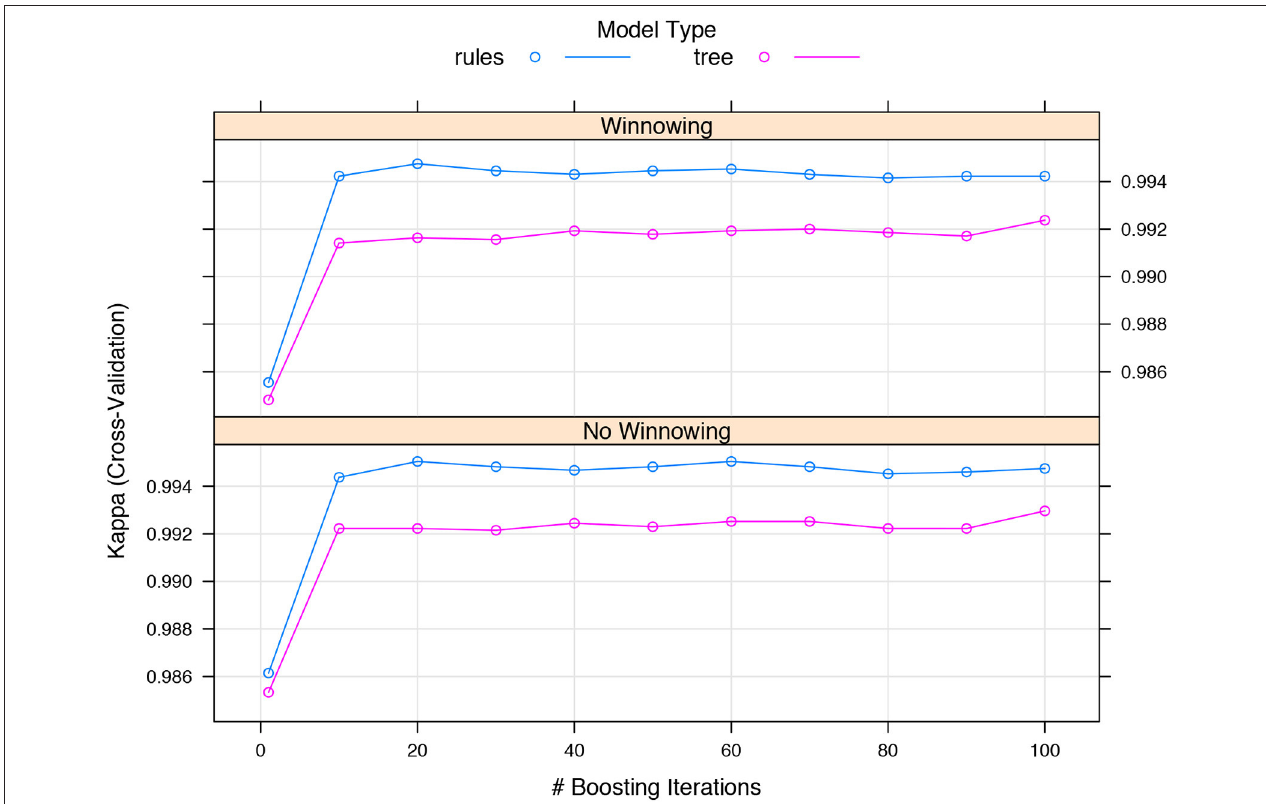
FIGURE 8 | Performance evaluation of C5.0 algorithm using 10-fold cross validation.